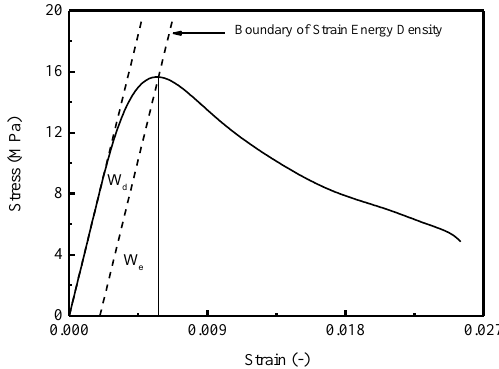
Figure 6. Schematic diagram of dividing model of strain energy density.